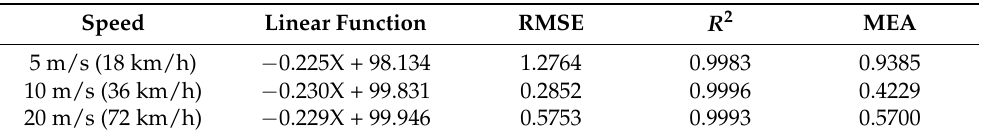
Table 6. The effect of a drone’s speed on the performance; the results are presented for location #1 and an altitude of 200 m, at various